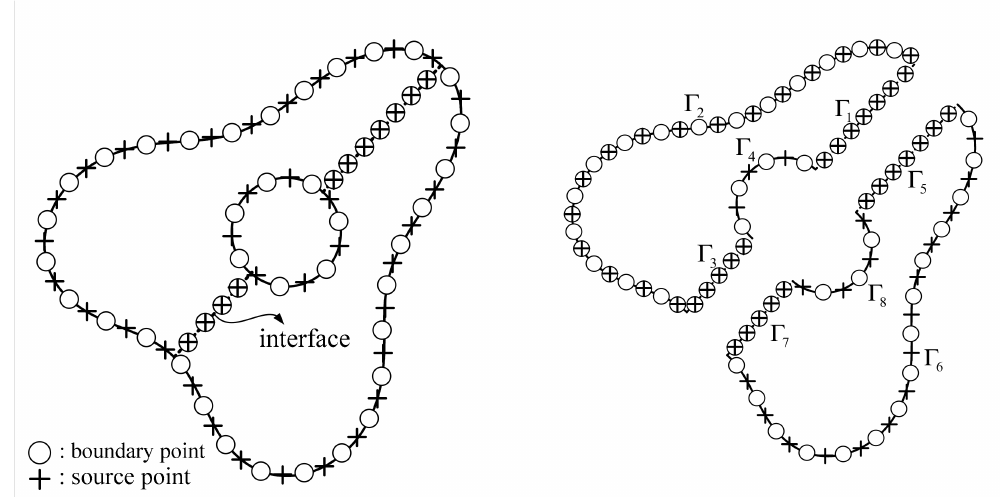
Figure 5. Illustration of the domain decomposition method (DDM) for a doubly-connected domain.